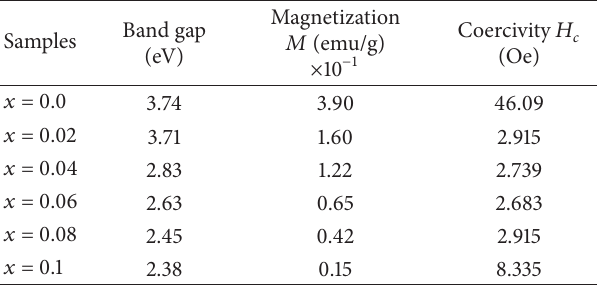
Table 1: Band gap energy, magnetization, and coercivity